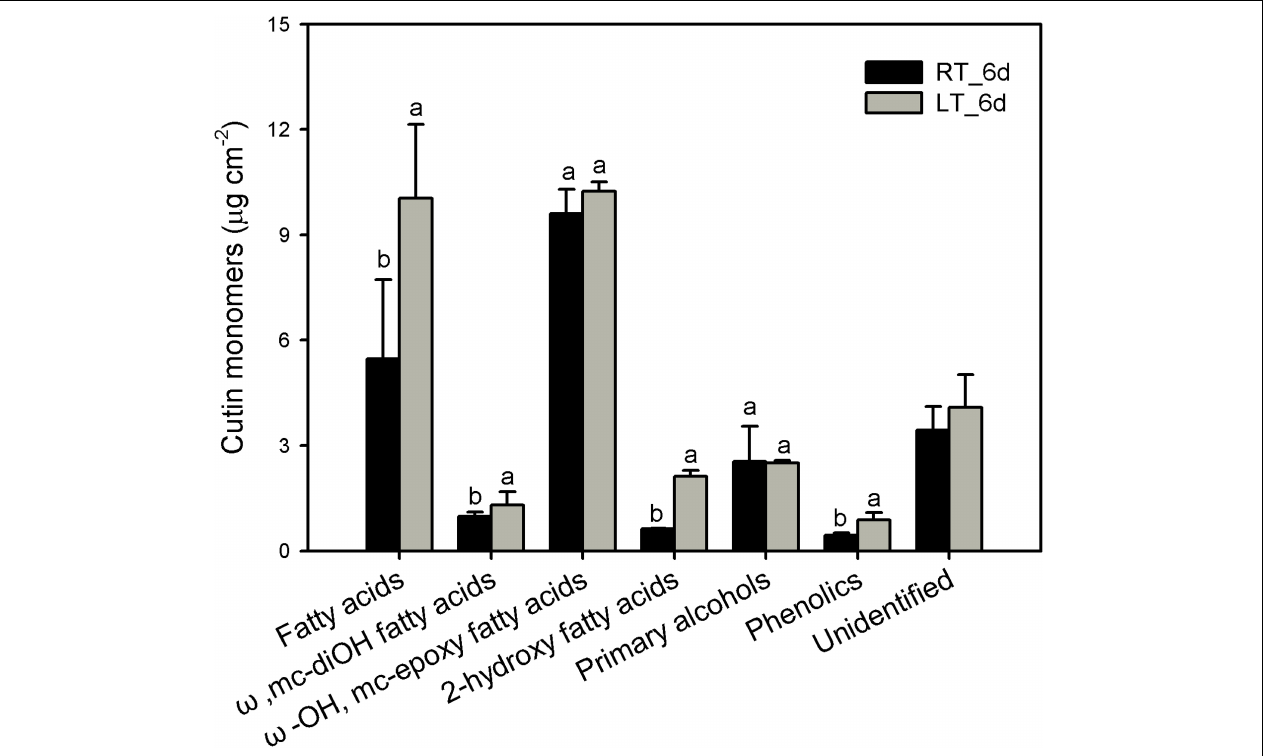
FIGURE 3 | Chemical compositions of cutin monomers in banana fruit cuticle stored under 4 ◦ C (low temperature, LT) and 25 ◦ C (room temperature, RT) at 6 days. Data are given as mean ± SD ( n = 5). Letters indicate the significant differences at the 0.05 level.